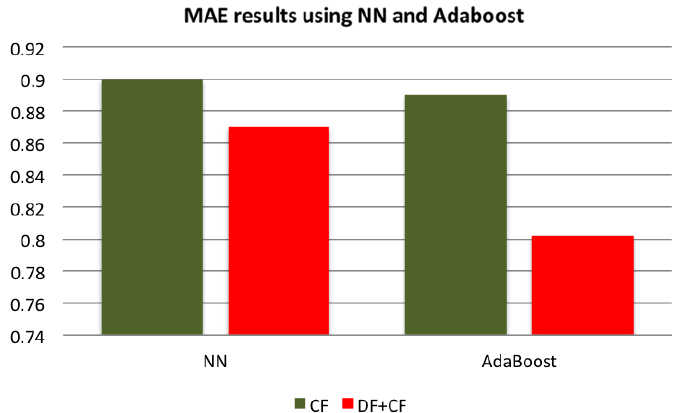
Fig. 4. MAE results for the MovieLens dataset using NN and AdaBoost.